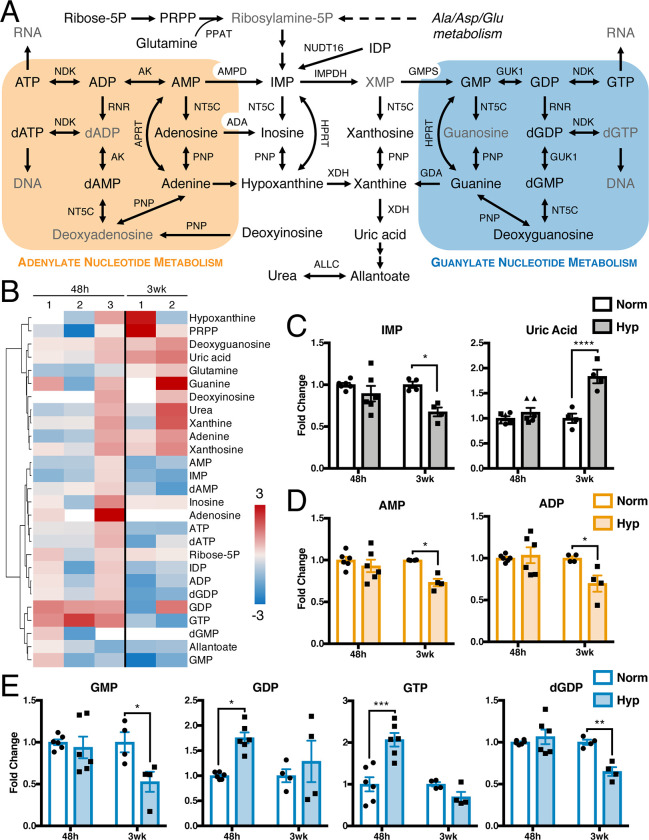
Purine nucleotides are decreased in long-term hypoxia.(A) Metabolites and enzymes in purine metabolism. Metabolites in gray not measured or detected. (B) Fold change metabolite abundance over normoxia control for metabolites from pathway in A detected in more than one sample. White space indicates metabolite not detected. (C-E) Significantly altered metabolites from B. Significance by two-way ANOVA. All error bars represent SEM, different symbols represent biological replicates. *, p < 0.05; **, p < 0.01; ***, p < 0.001; ****, p < 0.0001. Enzyme abbreviations: ADA, adenosine deaminase; AK, adenosine kinase; ALLC, allantoicase; AMPD, AMP deaminase; GDA, guanine deaminase; GMPS, GMP synthase; GUK1, guanylate kinase; HPRT, hypoxanthine-guanine phosphoribosyltransferase; IMPDH, IMP dehydrogenase; NDK, nucleoside diphosphate kinase; NT5C, 5', 3'-nucleotidase, cytosolic; NUDT16, IDP phosphatase; PNP, purine nucleoside phosphorylase; PPAT, phosphoribosyl pyrophosphate amidotransferase; RNR, ribonucleoside-diphosphate reductase; XDH, xanthine dehydrogenase. Metabolite abbreviations: ADP, adenosine diphosphate; AMP, adenosine monophosphate; ATP, adenosine triphosphate; dADP, deoxyadenosine diphosphate; dAMP, deoxyadenosine monophosphate; dATP, deoxyadenosine triphosphate; dGDP, deoxyguanosine diphosphate; dGMP, deoxyguanosine monophosphate; dGTP, deoxyguanosine triphosphate; GDP, guanosine diphosphate; GMP, guanosine monophosphate; GTP, guanosine triphosphate; IDP, inosine diphosphate; IMP, inosine monophosphate; PRPP, phosphoribosyl pyrophosphate; Ribose-5P, ribose 5-phosphate; XMP, xanthosine monophosphate.